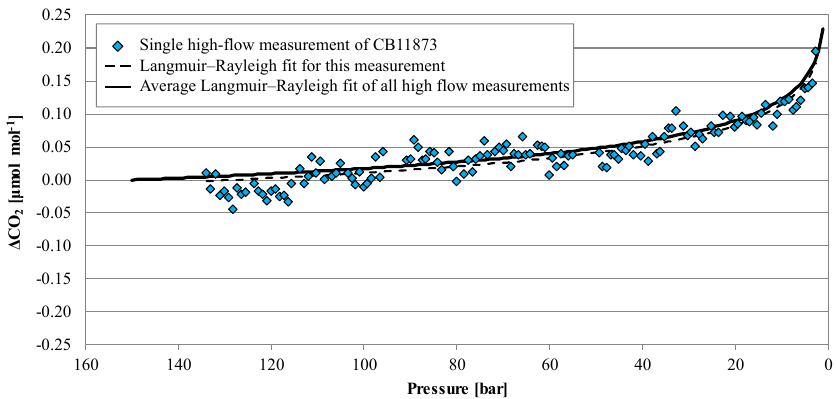
Figure 8. The blue diamonds represent the CO 2 mole fraction measurement of the high-flow experiment done on 5 April 2017 with CB11873 vertically positioned as a function of pressure; note the inverse pressure scale. The black dashed line is a fit following the combined Langmuir adsorption–desorption and Rayleigh distillation model; the black solid line represents the average of the combined Langmuir and Rayleigh fit using all high-flow experiments with vertically positioned cylinders. In order to plot all data in one plot, the corresponding ( X CO X CO ) was subtracted from the measurements and the 2 , ad